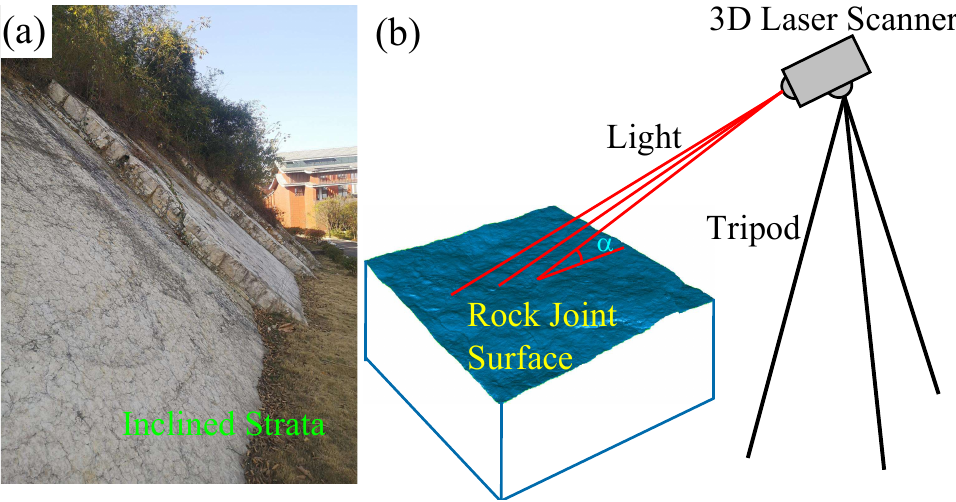
Figure 2. Reasons for non-stationary point clouds. ( a ) Joint surface with an inclination angle; ( b ) Non-perpendicular application of light from a 3D laser scanner to the joint